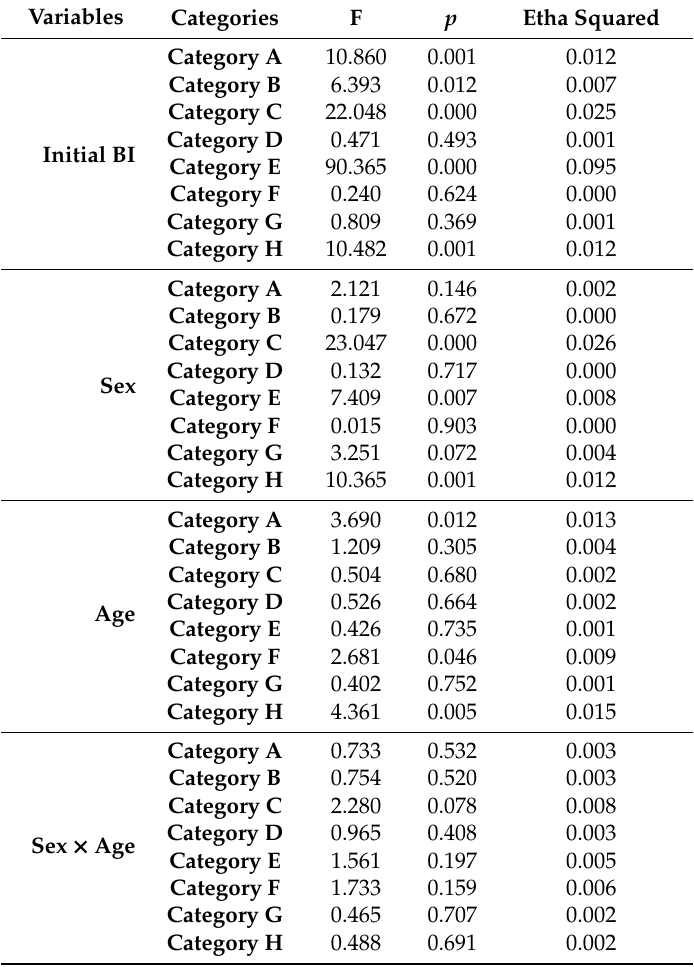
Table 4. Multivariate analysis (MANCOVA) analysis performed to assess the influence of clinical categories, sex, age, and initial BI (Barthel